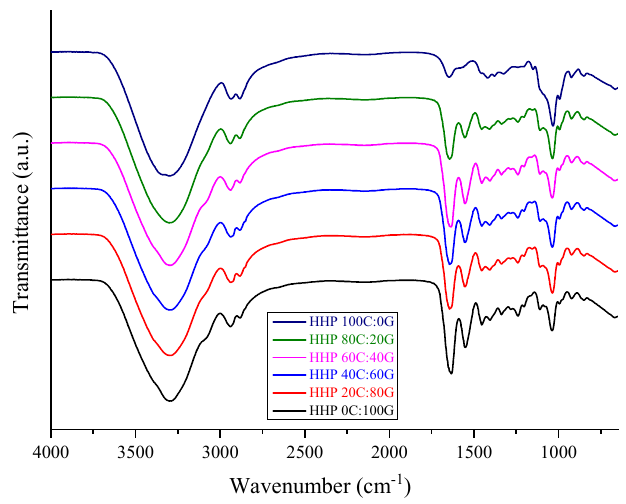
Figure 1. FTIR spectra of gelatin-based film incorporated with commercial chitosan ( A ), untreated chitosan ( B ), and HHP chitosan ( C ).